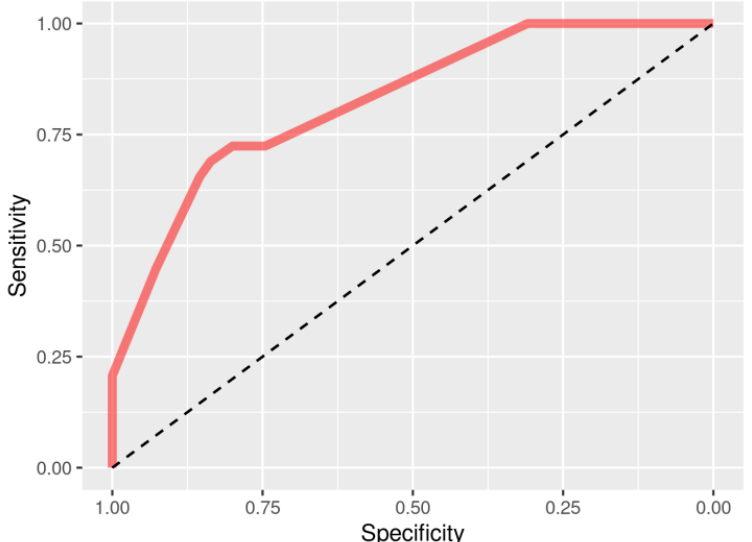
Figure 3. ROC curve analysis for selected variants.